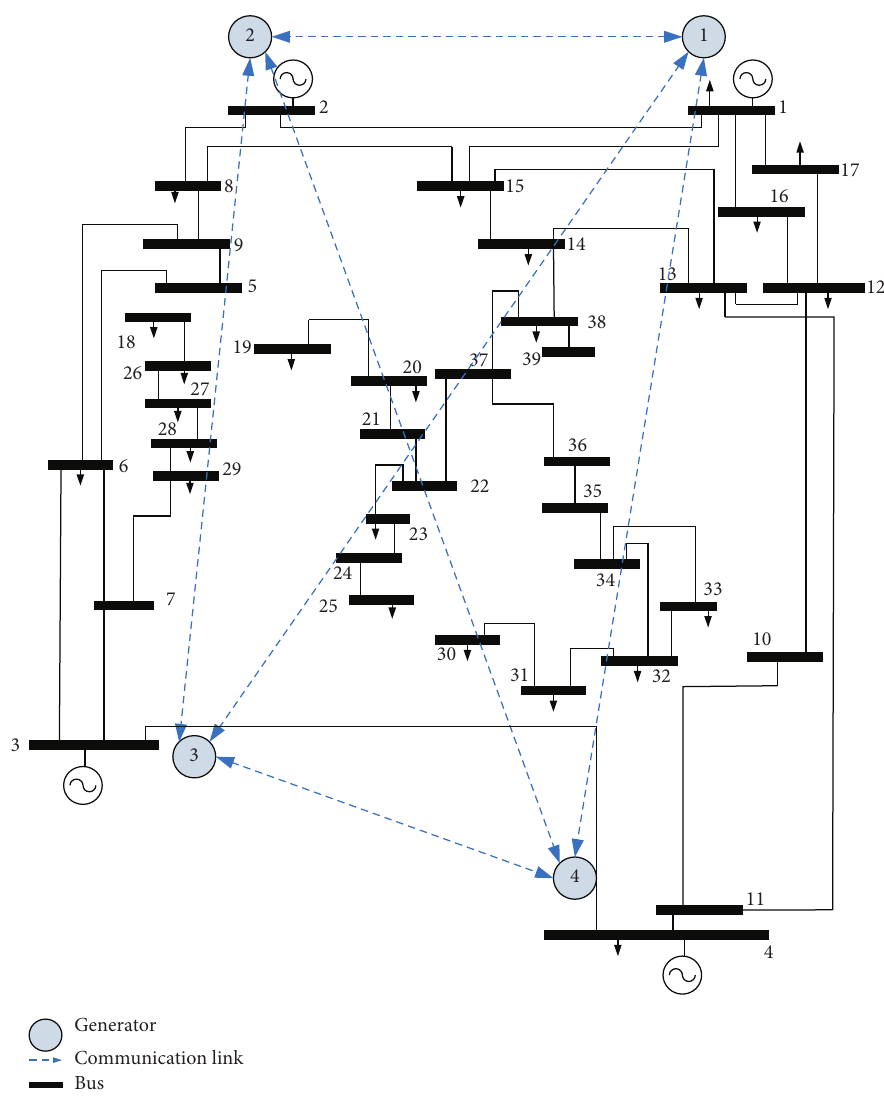
Figure 6: IEEE 39-bus